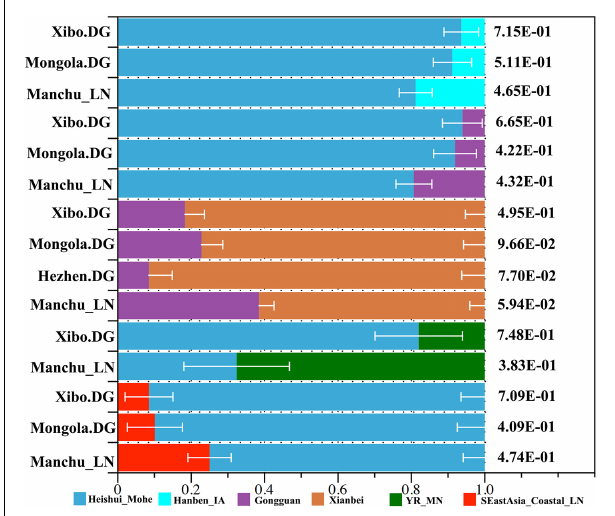
FIGURE 7 | Model of ancient population admixture by qpWave and qpAdm method. All of these ancestral components were revealed by different colors.